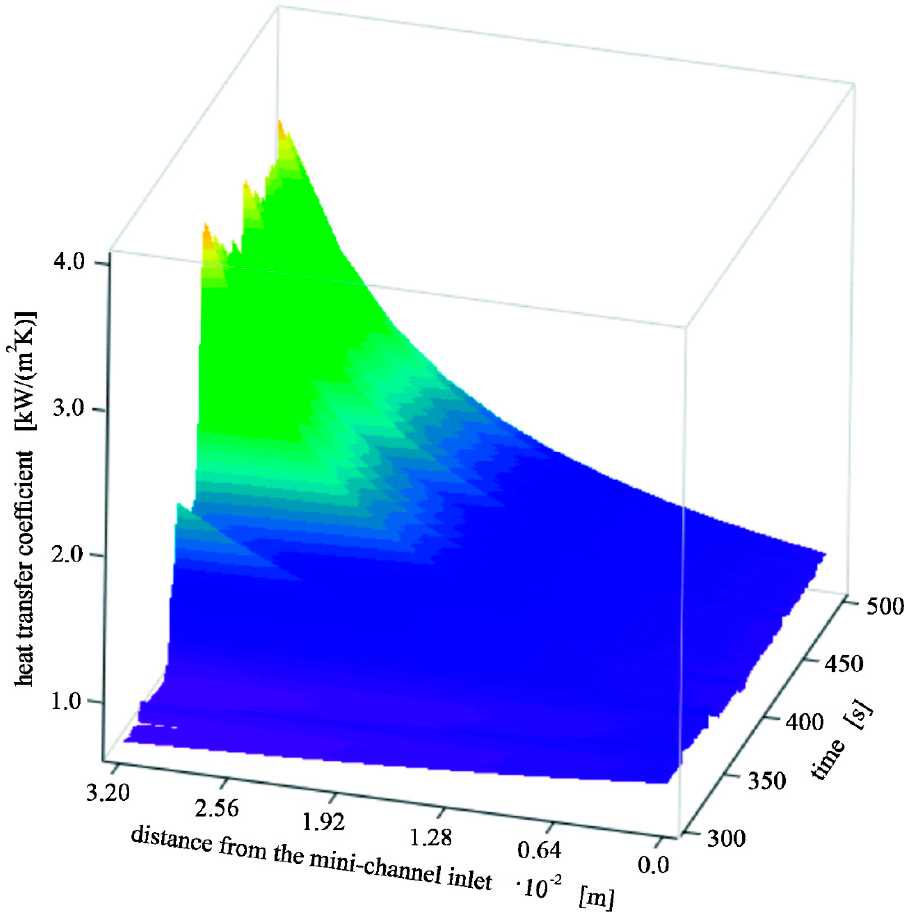
Figure 15. Heat transfer coefficient according to the HPTM computation versus time and distance from the mini-channel inlet; experimental parameters are listed in Table 1.